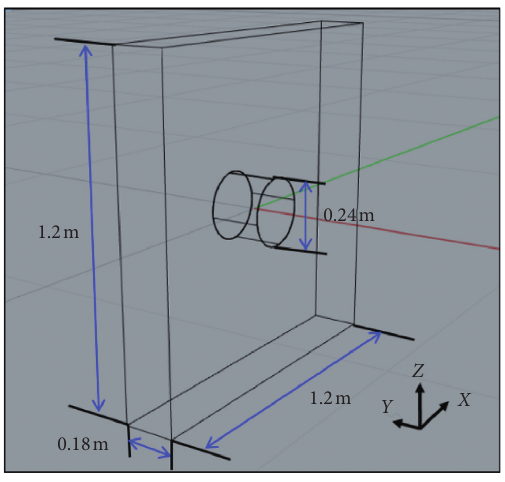
Figure 13: Dimensions of the wellbore stability test